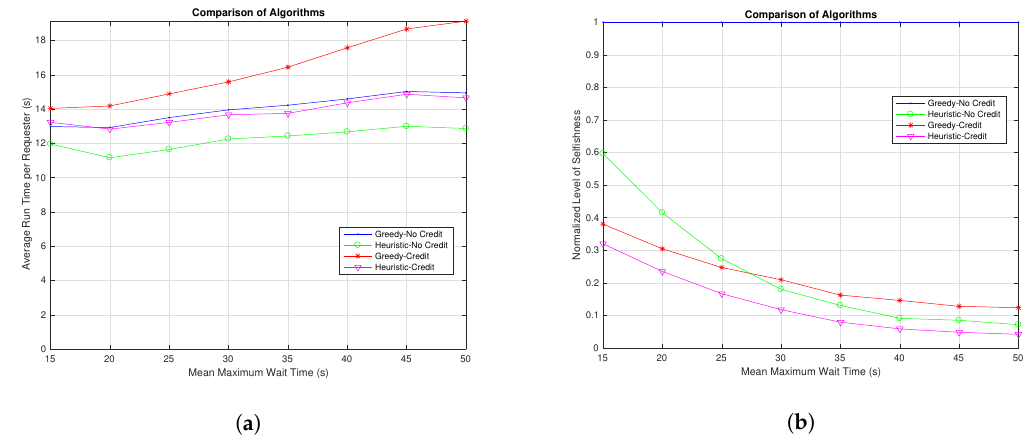
Figure 6. Effect of mean maximum wait time. ( a ) Effect on average task execution time; ( b ) effect on the level of